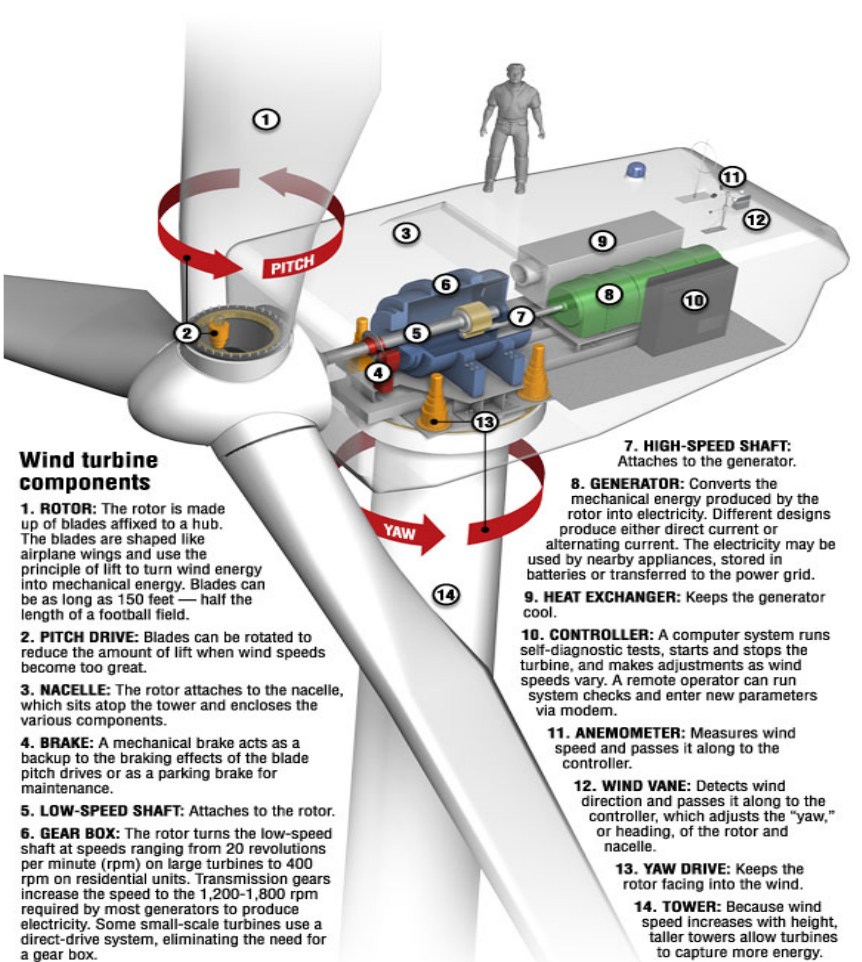
Figure 5. Typical configuration of a modern large scale wind turbine